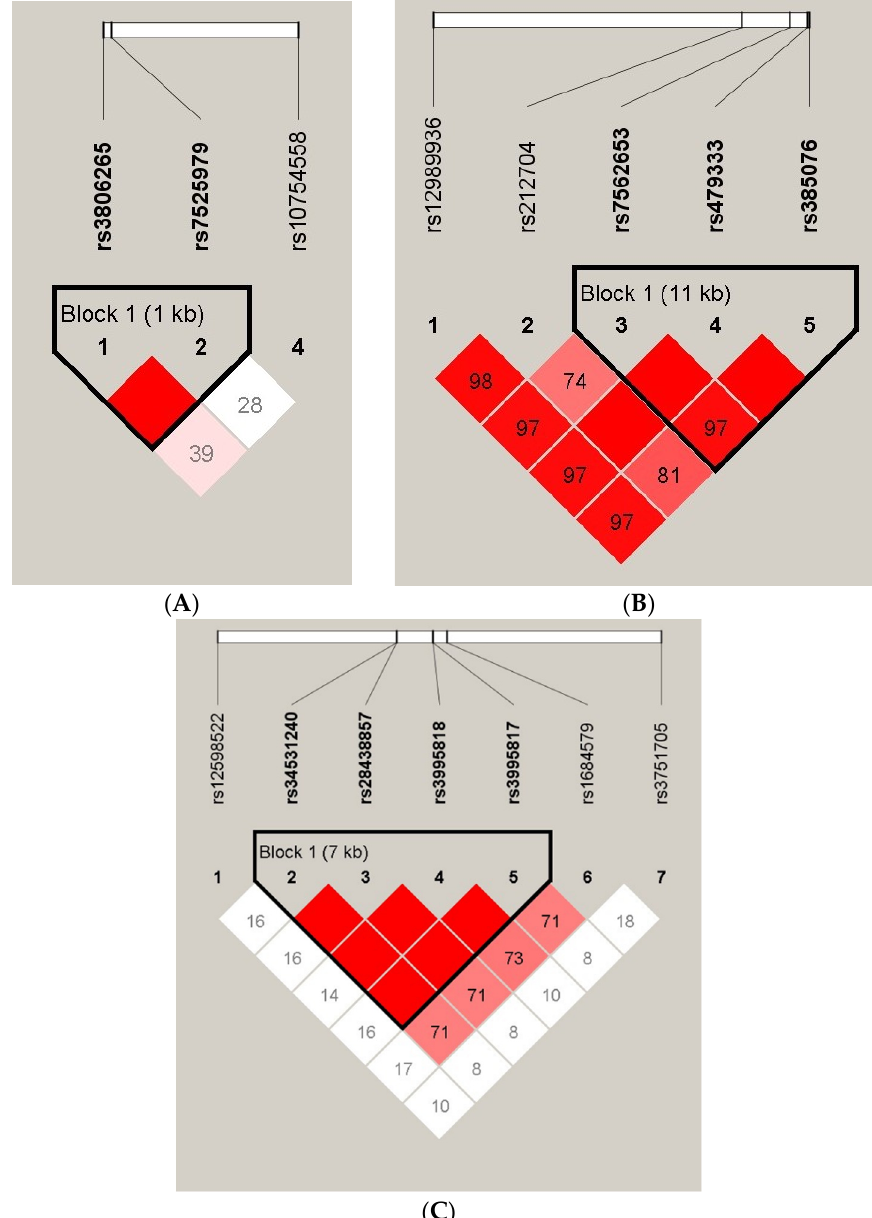
Figure 1. A linkage disequilibrium (LD) plot of NLR SNPs for all aspergillosis patients and controls. The D’ value of each SNP pair is represented as a percentage and shown in the square (D’ ≥ 0.99 not shown). Red squares indicate strong pairwise linkage disequilibrium. ( A ) The two NLRP3 SNPs (rs3806265, rs7525979) constitute a haplotype block spanning 1 kb of the NLRP3 gene with an extremely high pair-wise D ′ ≥ 0.99. ( B ) The three NLRC4 SNPs (rs385076, rs47933, rs7562653) constitute a haplotype block spanning 11 kb of the NLRC4 gene ( C ) The four NLRC5 SNPs (rs34531240, rs28438857, rs3995818, rs3995817) constitute a haplotype block spanning 7 kb of the NLRC5 gene with an extremely high pair-wise D ′ ≥ 0.99.